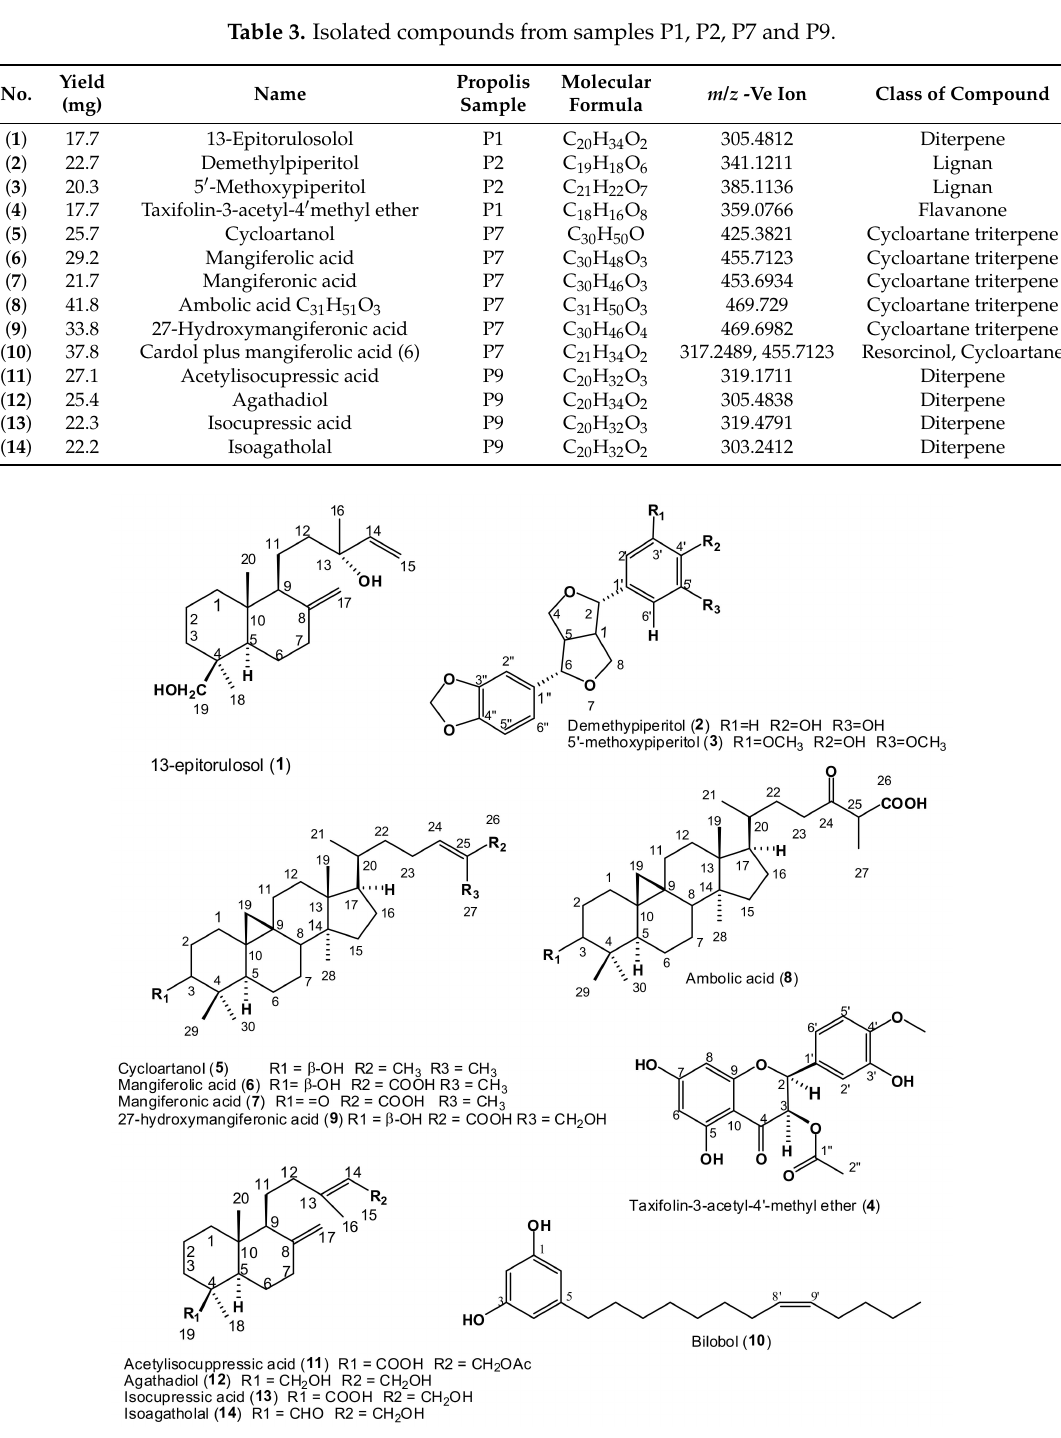
Figure 1. Structures of the compounds isolated from Libyan propolis in this